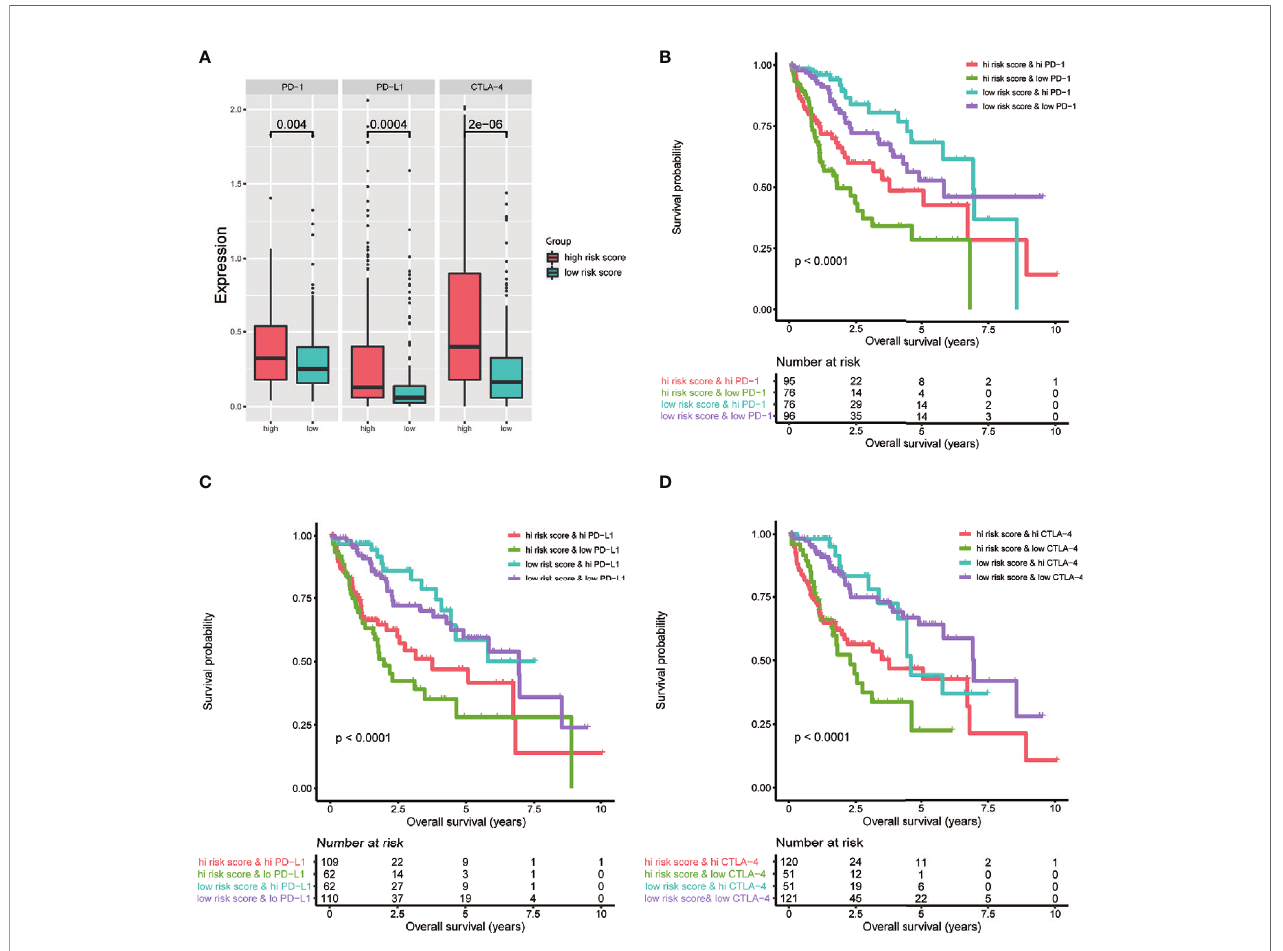
FIGURE 9 | Impact of the immune-related lncRNA signature and immune checkpoint gene expression on clinical outcome. (A) relationship between the immune- related lncRNA signature and immune checkpoint genes, the results showed that patients in high-risk group have higher expression of immune checkpoint genes than patients in low-risk group. Kaplan-Meier survival curves of overall survival among four patient groups strati fi ed by the immune-related lncRNA signature and PD-1 (B) , PD- L1 (C) and CTLA-4 (D)